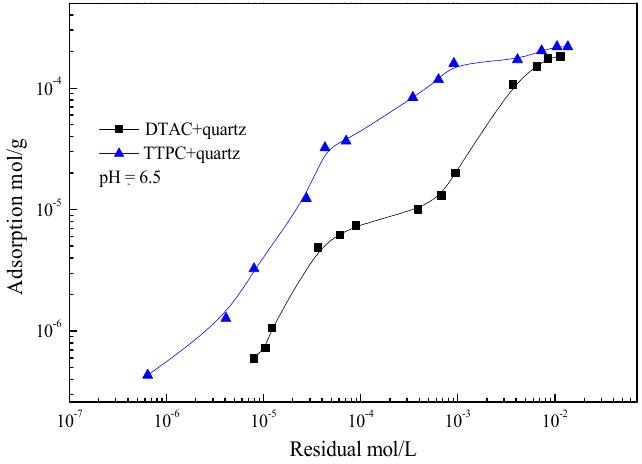
Figure 7. Adsorption isotherm of tributyltetradecyl-phosphonium chloride (TTPC) and dodecyl triethyl ammonium chloride (DTAC) on quartz surface.